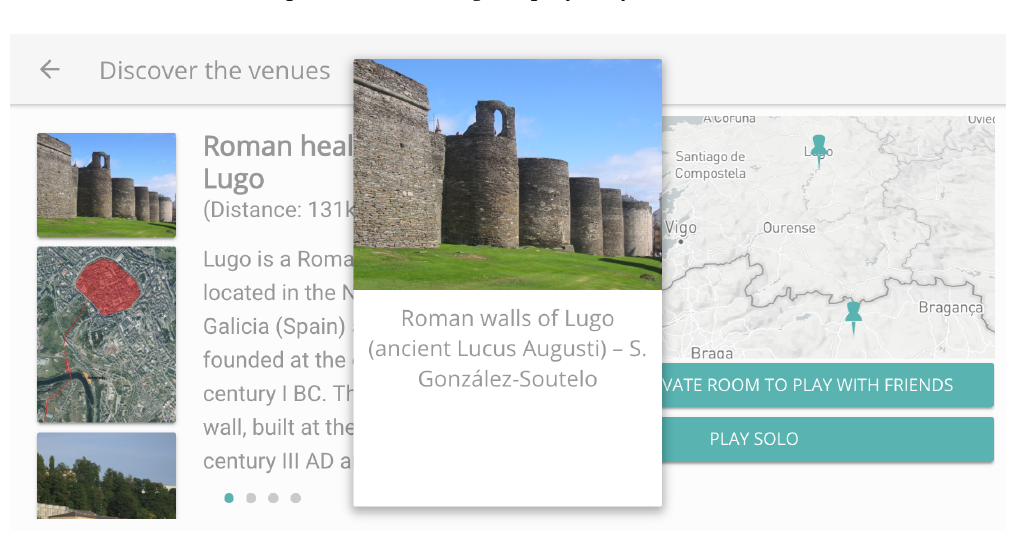
Figure 3. Initial presentation of the venues.